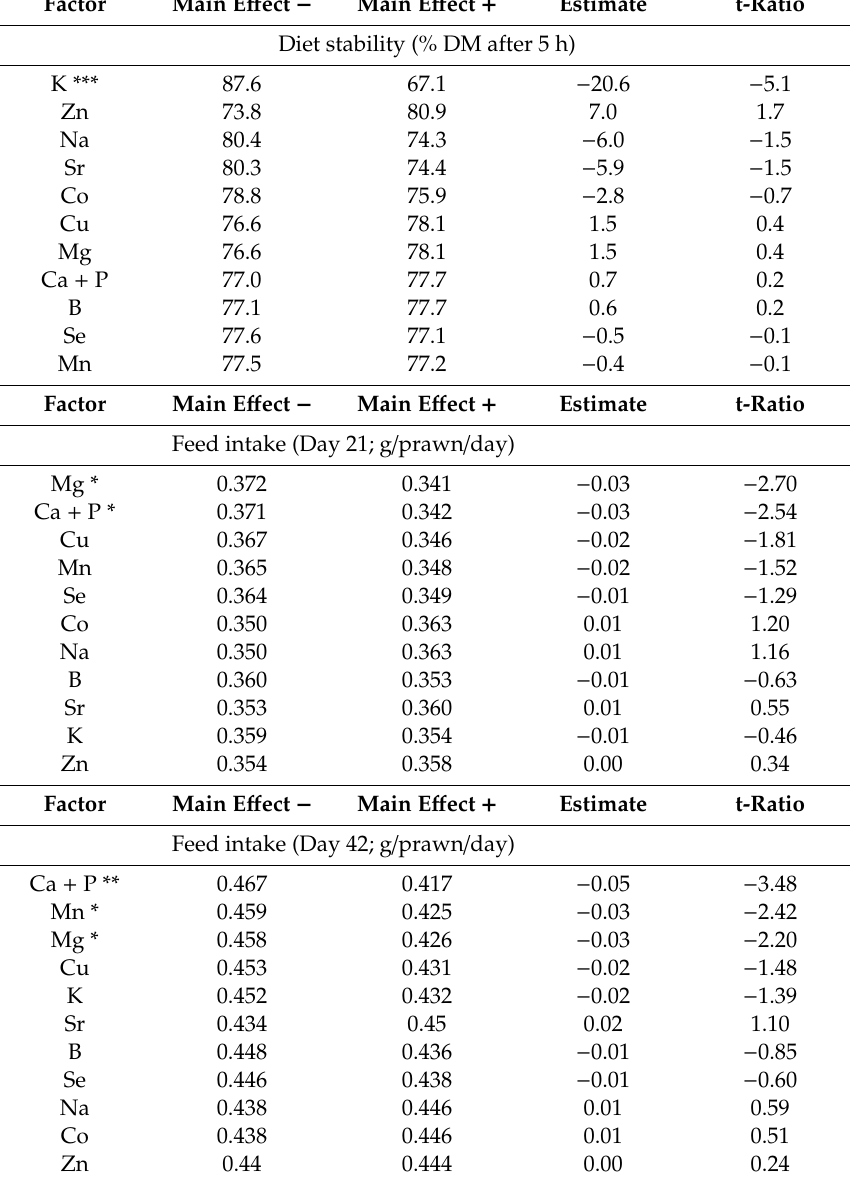
Table A2. E ff ect of twelve dietary minerals at two inclusion levels ( − /+ ) on diet stability (% DM after 5 h), feed intake (g / prawn / day) at day 21 and 42 and feed e ffi ciency (FE) at Day 21 and 42 over the 6-week trial period using two-level screening analysis. Factors are sorted by | estimates | and significant factors are marked by an asterisk (* p < 0.05, ** p < 0.01, *** p <